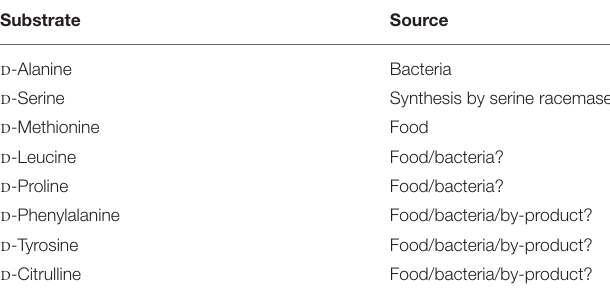
TABLE 2 | Physiological substrates of mouse DAO. TABLE 3 | Amounts of D -alanine in the tissues and physiological fluids of